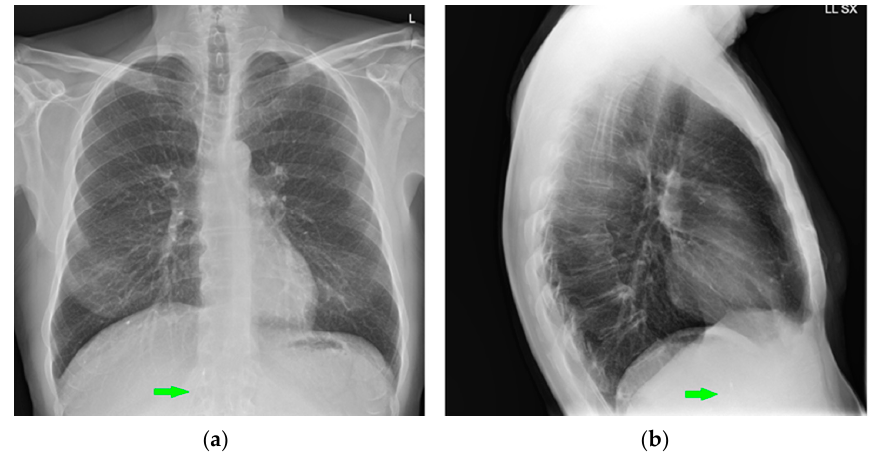
notomy (red arrows) and multiple outcomes of vertebroplasty (blue arrows).